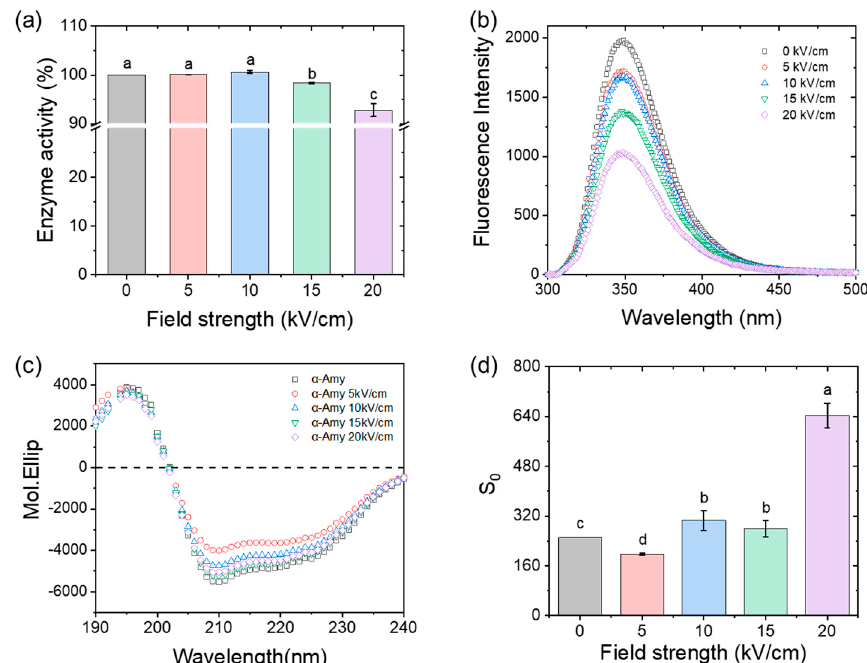
Figure 1. MG state of α -amylase induced by PEF (1 cycle). ( a ) Effect of electric field on enzyme activities, ( b ) intrinsic fluorescence intensity, ( c ) CD spectra, and ( d ) surface hydrophobicity. Letters a-d inserted in figures for degree of significance, p < 0.05.